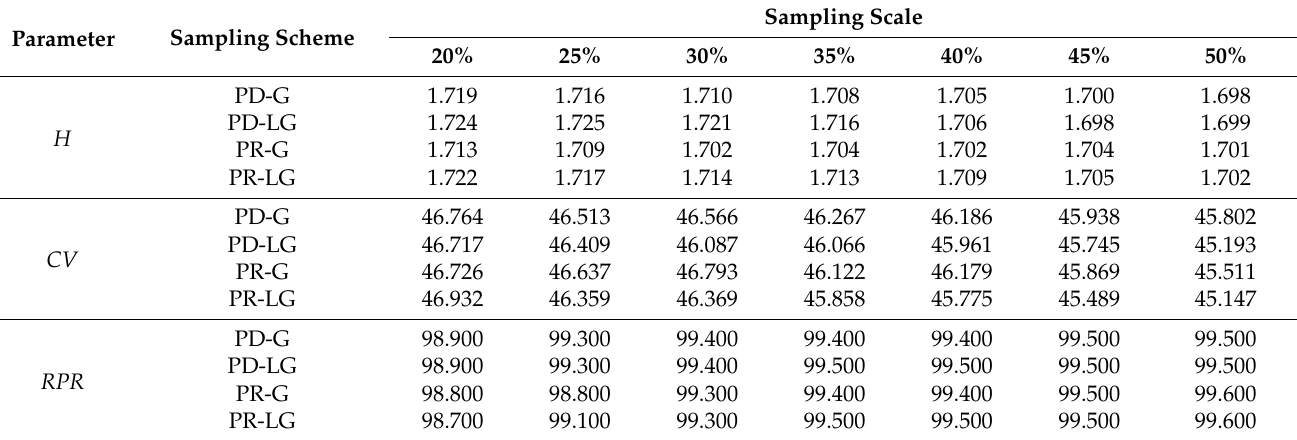
Table 8. Comparison of the sampling rations in candidate primary core